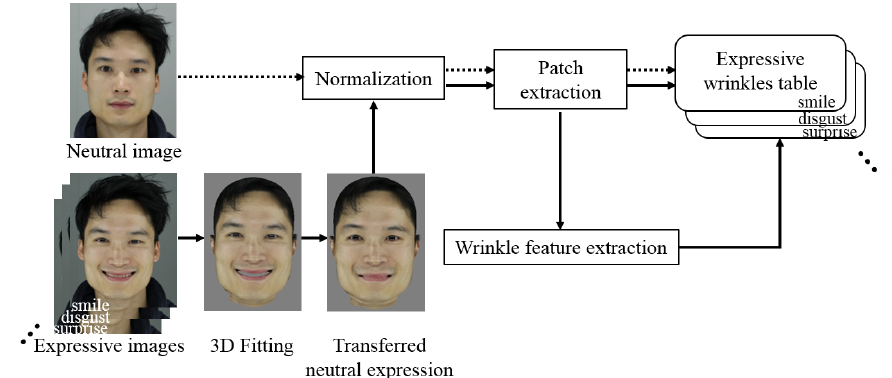
Figure 11. Process of building expression wrinkle table.